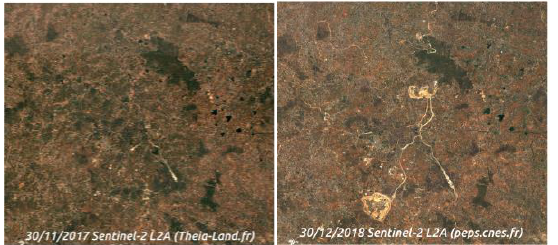
Figure 4: Konda Pochoma reservoir under construction, Gajwel Town, seen with Sentinel-2 satellites. Big reservoirs connected in